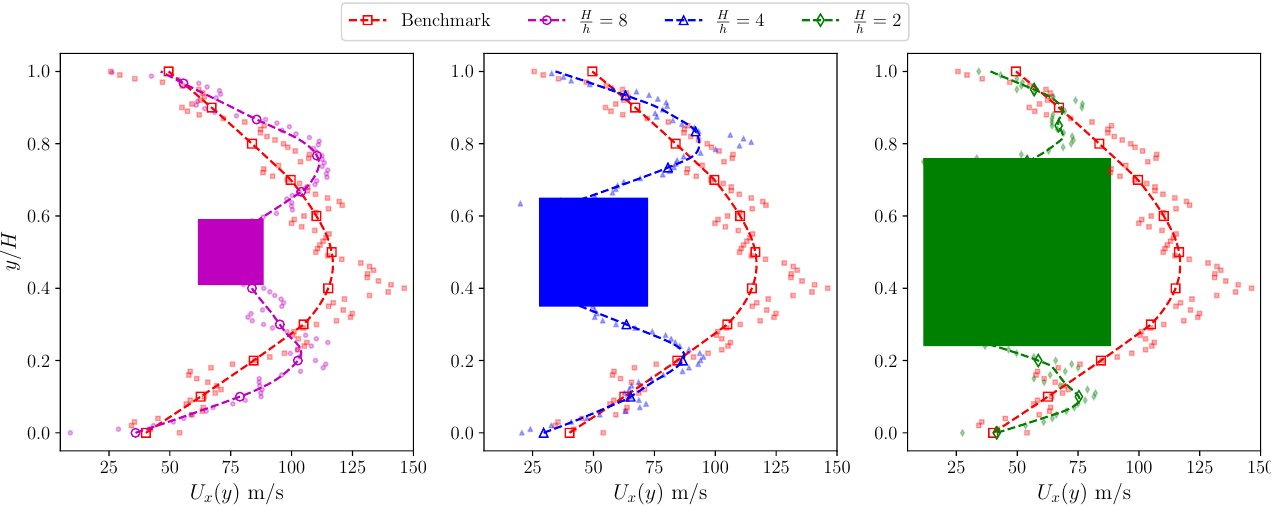
Figure 2. Comparison of the variations in co-axial velocity in the transition regime ( Kn = 0.1) along channel height H at the center of the channel x / L = 0.5 across the chosen blockage ratios H / h of 8, 4 and 2, respectively, with the benchmark case without a particle (represented by the dashed line with squares). In this figure, the square particle is used as an illustrative tool to mask the discontinuities in the region occupied by the particle. The open symbols represent the DSMC data, while the dashed lines represent the weighted least squares